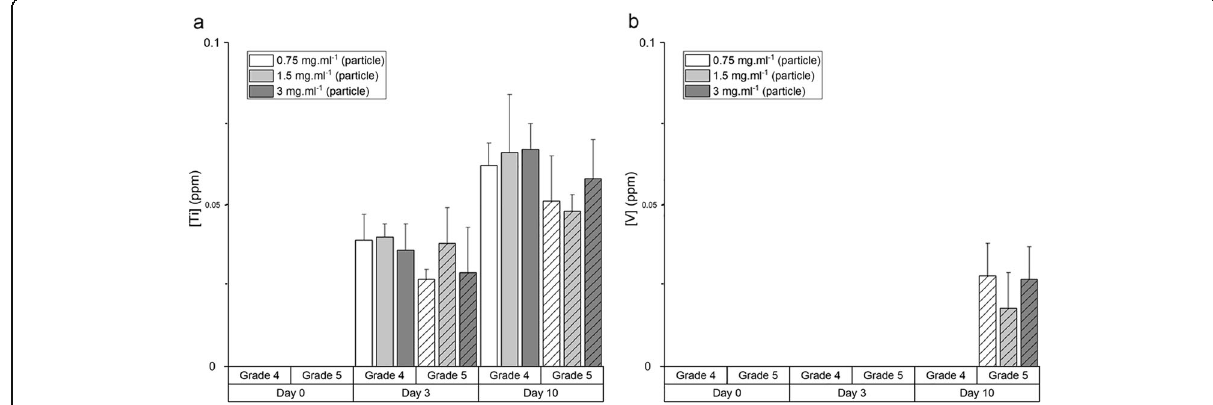
Fig. 3 Titanium (Ti) and vanadium (V) release from the particles in simulated body fluid (SBF). Experimental duration was 10 days. Results presented as mean ± standard deviation, n = 3